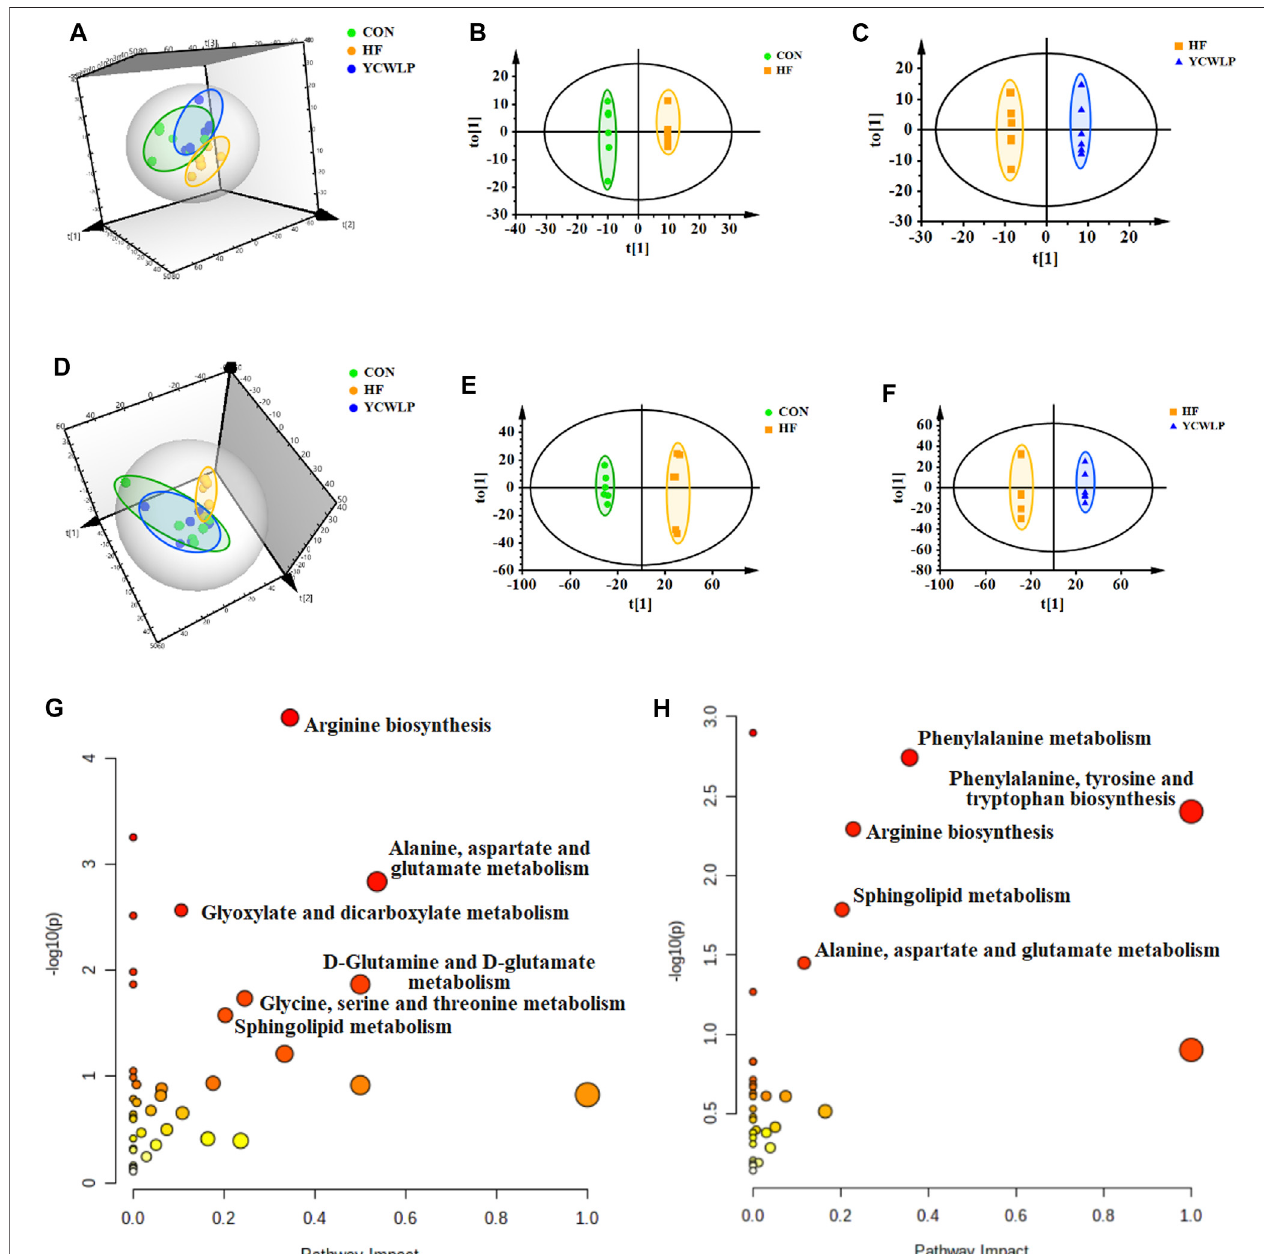
FIGURE 2 | Multivariate data analysis and the metabolic pathway analysis of the fecal samples. 3D PCA score plots ofthe CON, HF and YCWLP groups based on 1 H NMR (A) and UPLC-MS (D) , respectively; OPLS-DA score plots of the CON and HF groups based on 1 H NMR (B) and UPLC-MS (E) , respectively; OPLS-DA score plotsoftheHFandYCWLPgroupsbasedon 1 HNMR (C) andUPLC-MS (F) ,respectively.Meaningfulpathway analysisbasedonthekeyfecalmetabolitesbetweenthe CON and HF groups (G) and between the HF and YCWLP groups (H) , respectively ( p -value < 0.05, impact-value > 0.1).